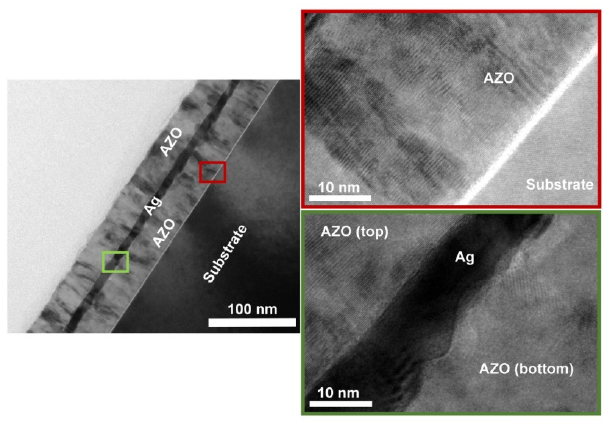
Figure 1. The cross-sectional TEM image of AZO/Ag/AZO [18].